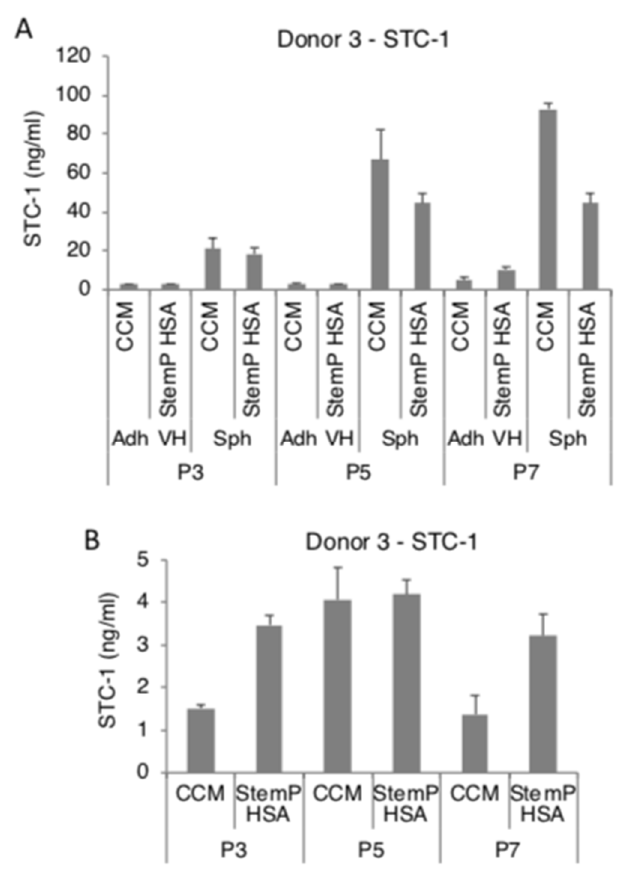
Figure 6. Spheroids generated from extensively expanded MSCs secrete high amounts of stanniocalcin 1 (STC-1). MSCs from various passages (3, 5, and 7) were cultured as spheroids and as very high density monolayers in FBS-containing and xeno-free media. The conditioned medium was harvested for STC-1 ELISA. Spheroids were also dissociated and the resulting cells were tested for their ability to maintain STC-1 secretion. ( A ) STC-1 secretion by spheroids and very high density monolayer MSCs in FBS-containing media and xeno-free media at di ff erent passages. ( B ) STC-1 secretion by spheroid-derived cells from FBS-containing media and xeno-free media at di ff erent passages. Abbreviations: Adh VH, adherent very high density monolayer MSCs; CCM, complete culture medium; P3, passage 3; Sph, spheroid MSCs; Sph DC, spheroid-derived MSCs; StemP HSA, StemPro xeno-free media with human serum albumin.